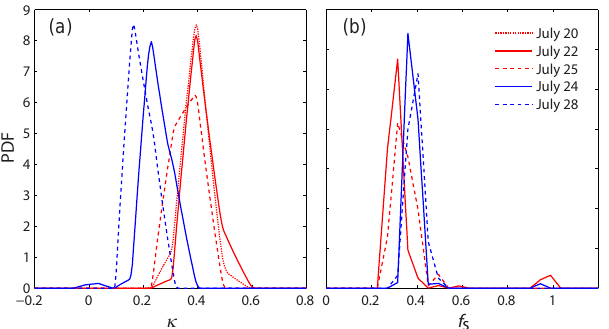
Figure 4. Average κ -PDF (a) and f s -PDF (b) of 50nm particles during the 5 NPF